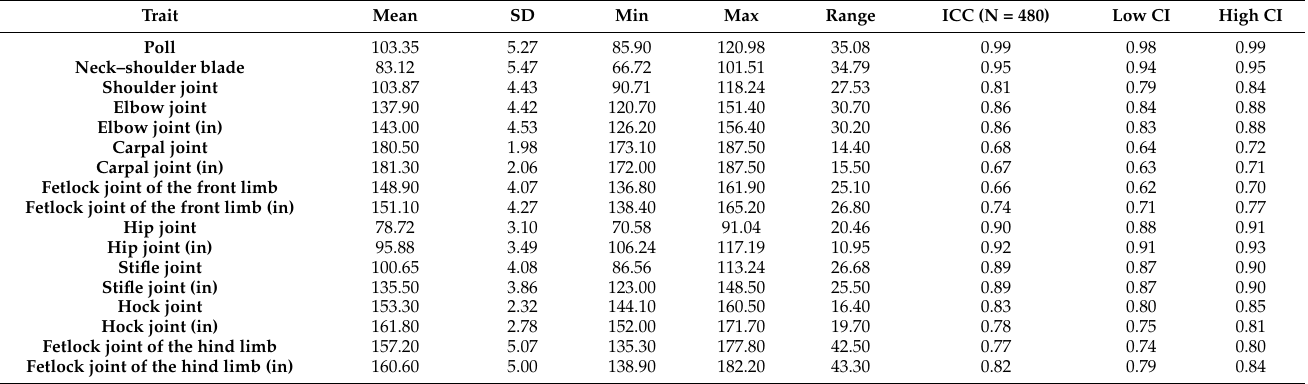
Table 2. Descriptive statistics and repeatability for photographs analysed in triplicate for each trait as an intra-class correlation coefficient with their 95% confidence intervals, for the joint